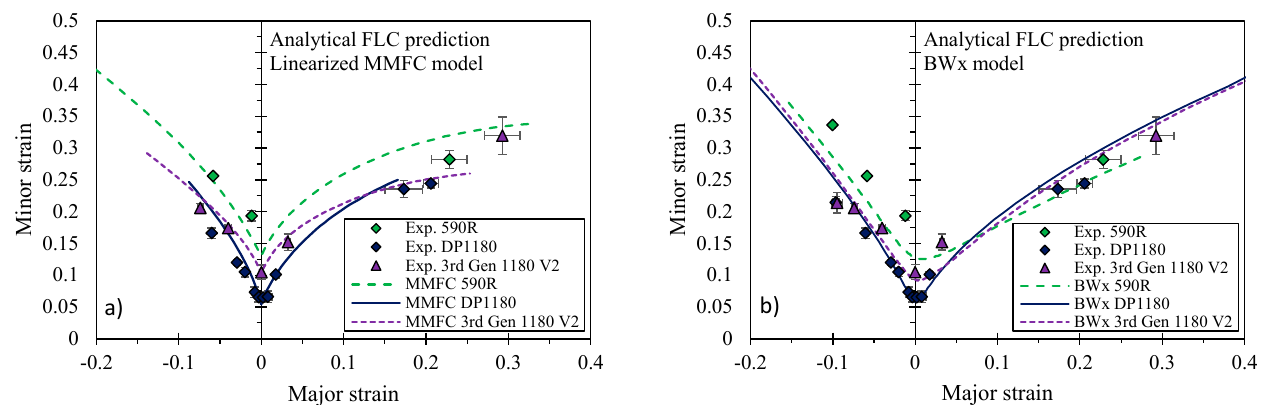
Figure 23. Formability prediction for in-plane stretching using the linearized MMFC ( a ) and the BWx model ( b ) for the 590R, DP1180, and the 3rd Gen 1180 V2.